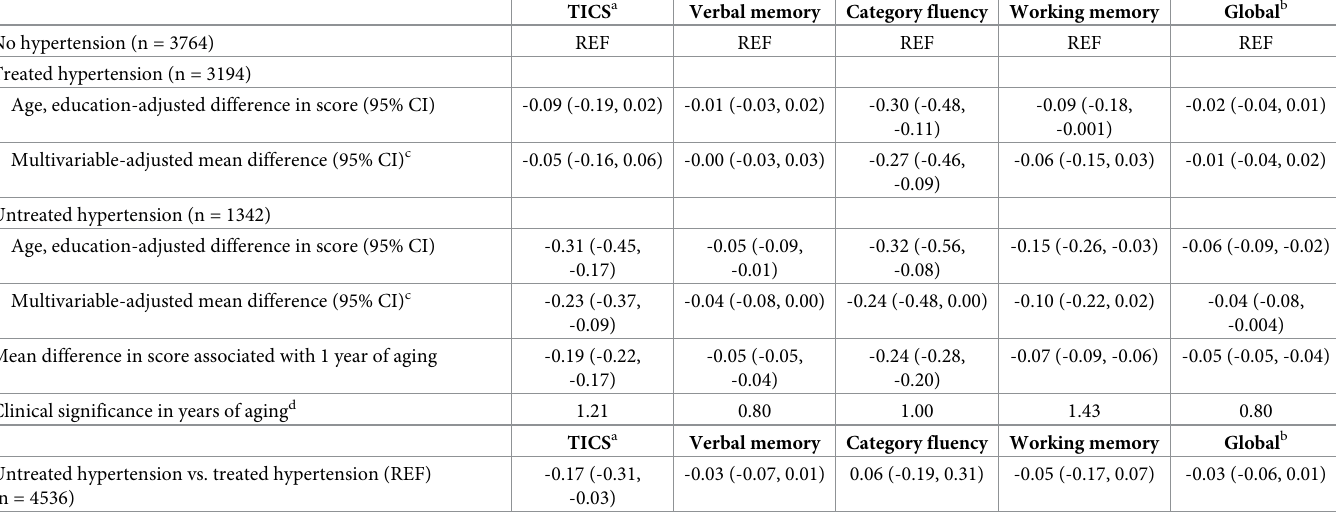
Table 2. Multivariable-adjusted mean differences (95% CI) in average cognitive performance in up to 4 assessments (1995–2008), by history of physician-diagnosed hypertension (n = 8300; 1995–2008), with and without